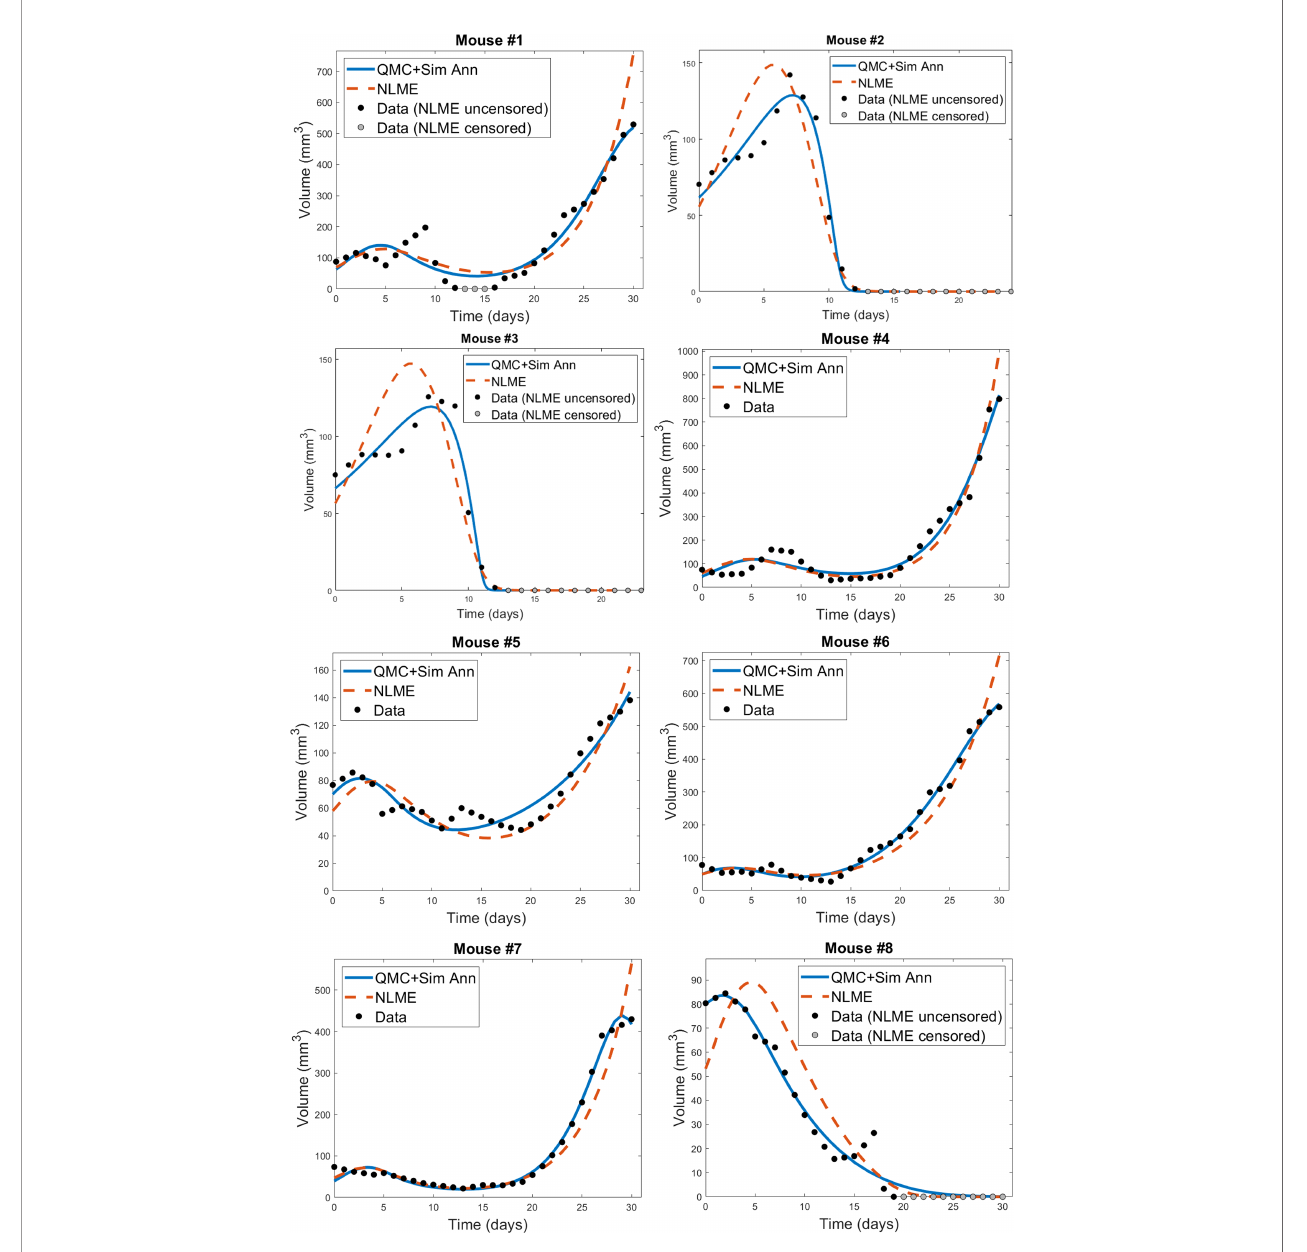
FIGURE 2 | Best- fi t for each mouse treated with Ad/41BBL/IL-12 and DCs in the order VDVDVD at a dose of 2.5 × 10 9 OVs and 10 6 DCs (34). The QMC fi ts (in which each mouse is treated independently of the others) are shown in blue, and the NLME fi ts are shown in red. The experimental data (black if uncensored for NLME fi tting, grey if censored) is also provided on each